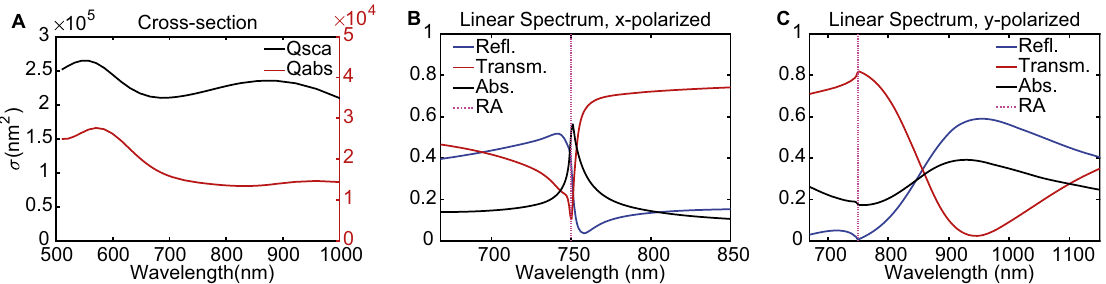
Figure2: (Coloronline)(A)Scatteringandabsorptioncross-sectionsforasinglegoldspherewith r =100nmnumericallycalculatedwithFDTD method. Re fl ection, transmission, and absorption spectra for the nanoparticle array with (B) x -polarized and (C) y -polarized incident electric fi elds. The vertical dotted line denotes the wavelength of the 〈 1 , 0 〉 Rayleigh anomaly. Note that the spectral ranges are different and adjusted to enlarge regions containing narrow resonant features. In (B), a minimum in the re fl ection nearly coincides with a maximum in the trans- missionand both are close to themaximumof absorption, where theEQ lattice resonance is excited.In the panel C, a comparatively broad ED resonance is excited around the wavelength 950 nm with a small feature present near the Rayleigh anomaly wavelength at the wavelength 750 long attenuation lengths (asymmetrically) above and below the lattice plane at the antinodes of the lattice standing wave [29].